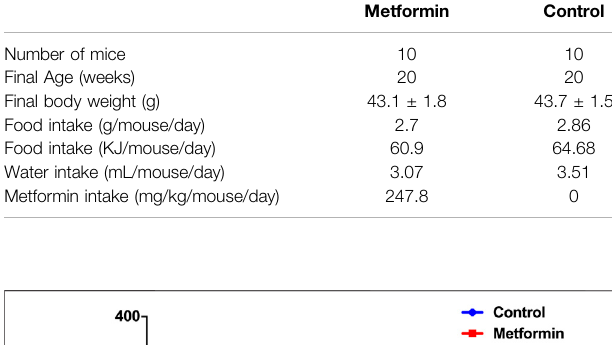
FIGURE 1 | Weight trajectory of metformin and control groups over the periodof8 weeks.Datawaspresentedasmean±standarderrorofthemean. The arrow denotes the start of metformin or placebo treatment.